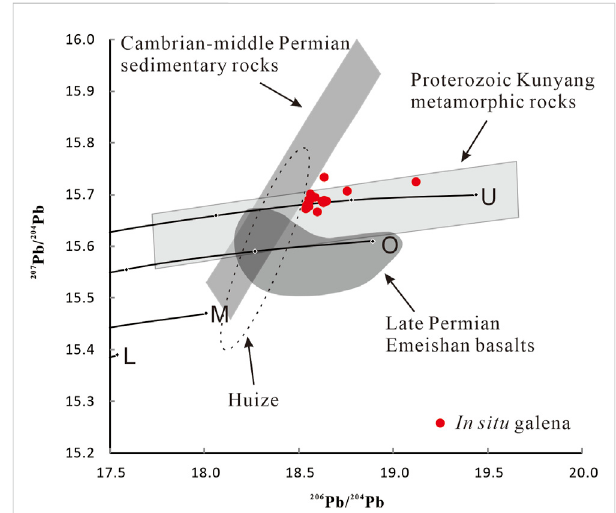
FIGURE 9 A comparison of sulfur isotopic compositions between the Pb- Zn deposits located in different strata ages of the SYG metallogenic province,seawaterandmantle-derivedsulfur(modi fi edafterClaypool et al., 1980). The data sourced from (Chaussidon et al., 1989; Huangetal., 2004;Zhou etal.,2010;2013b;2013c;2013a;Yuan etal., 2014; Wei et al., 2021).